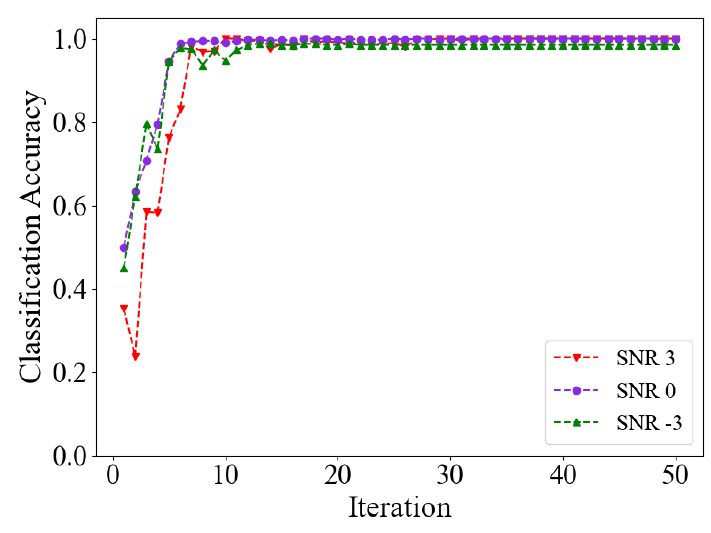
Figure 15. The results of model training on different noise levels (testing on CWRU dataset).